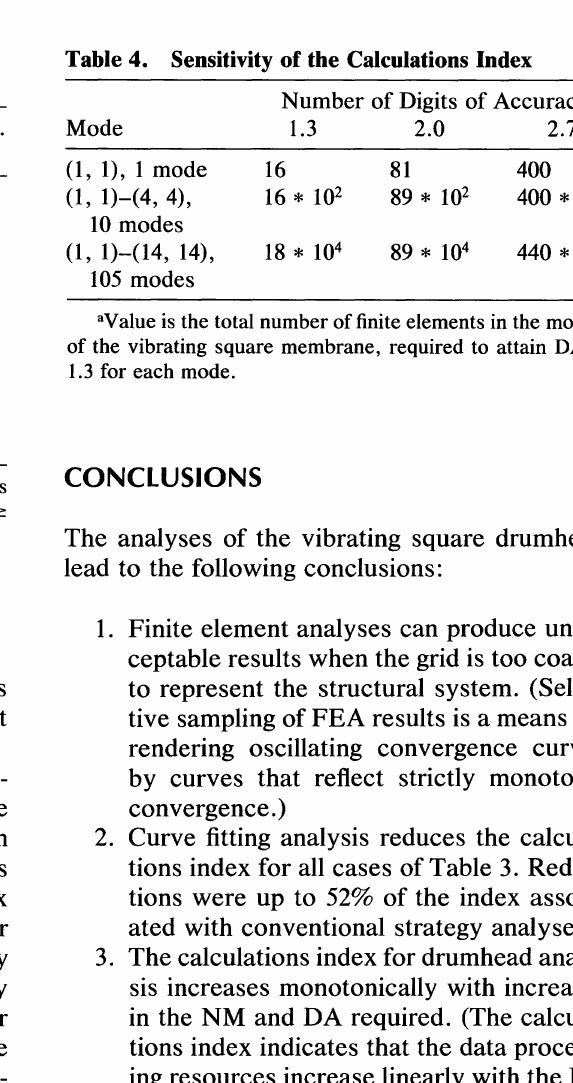
Table 4. Sensitivity of the Calculations Index Number of Digits of